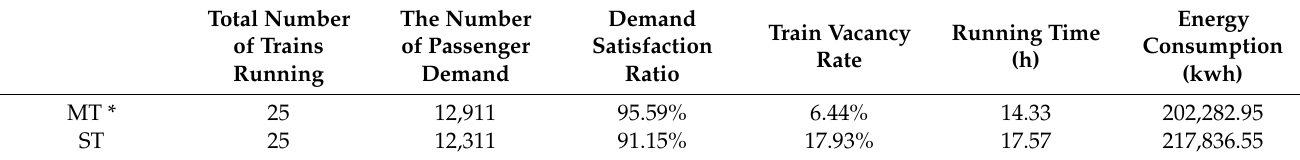
Table 7. Comparison of metrics in scenario 1.